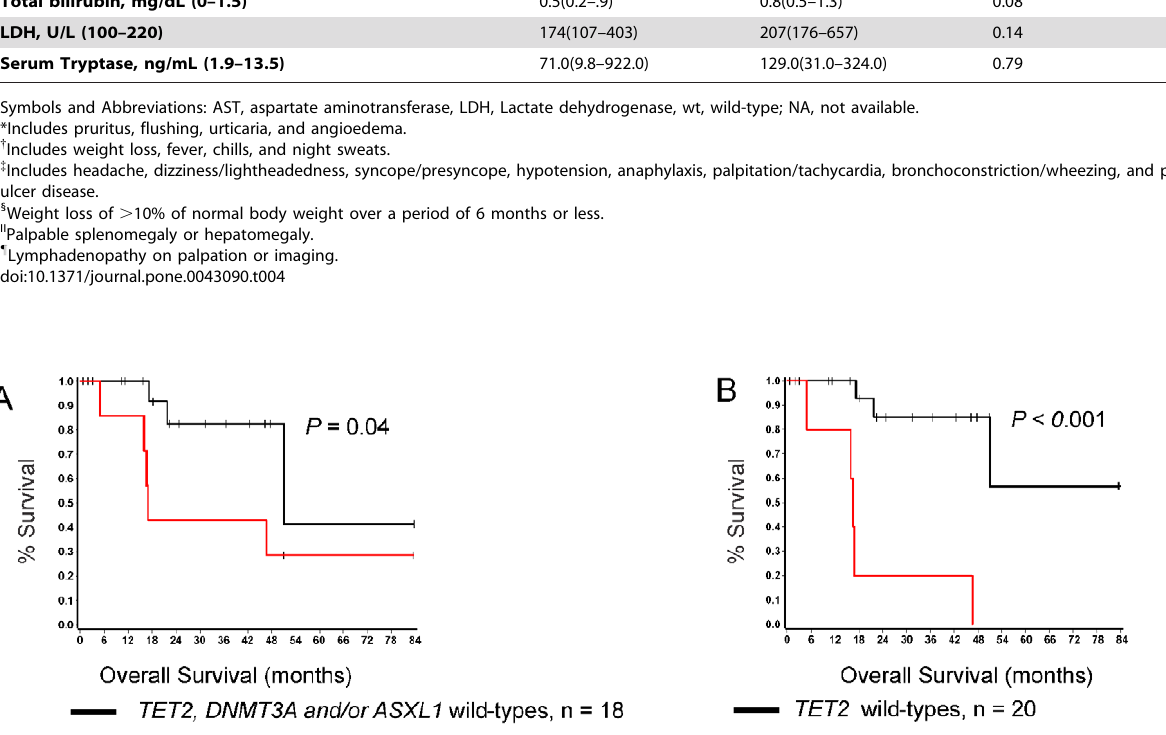
TET2 wt TET2 mutant